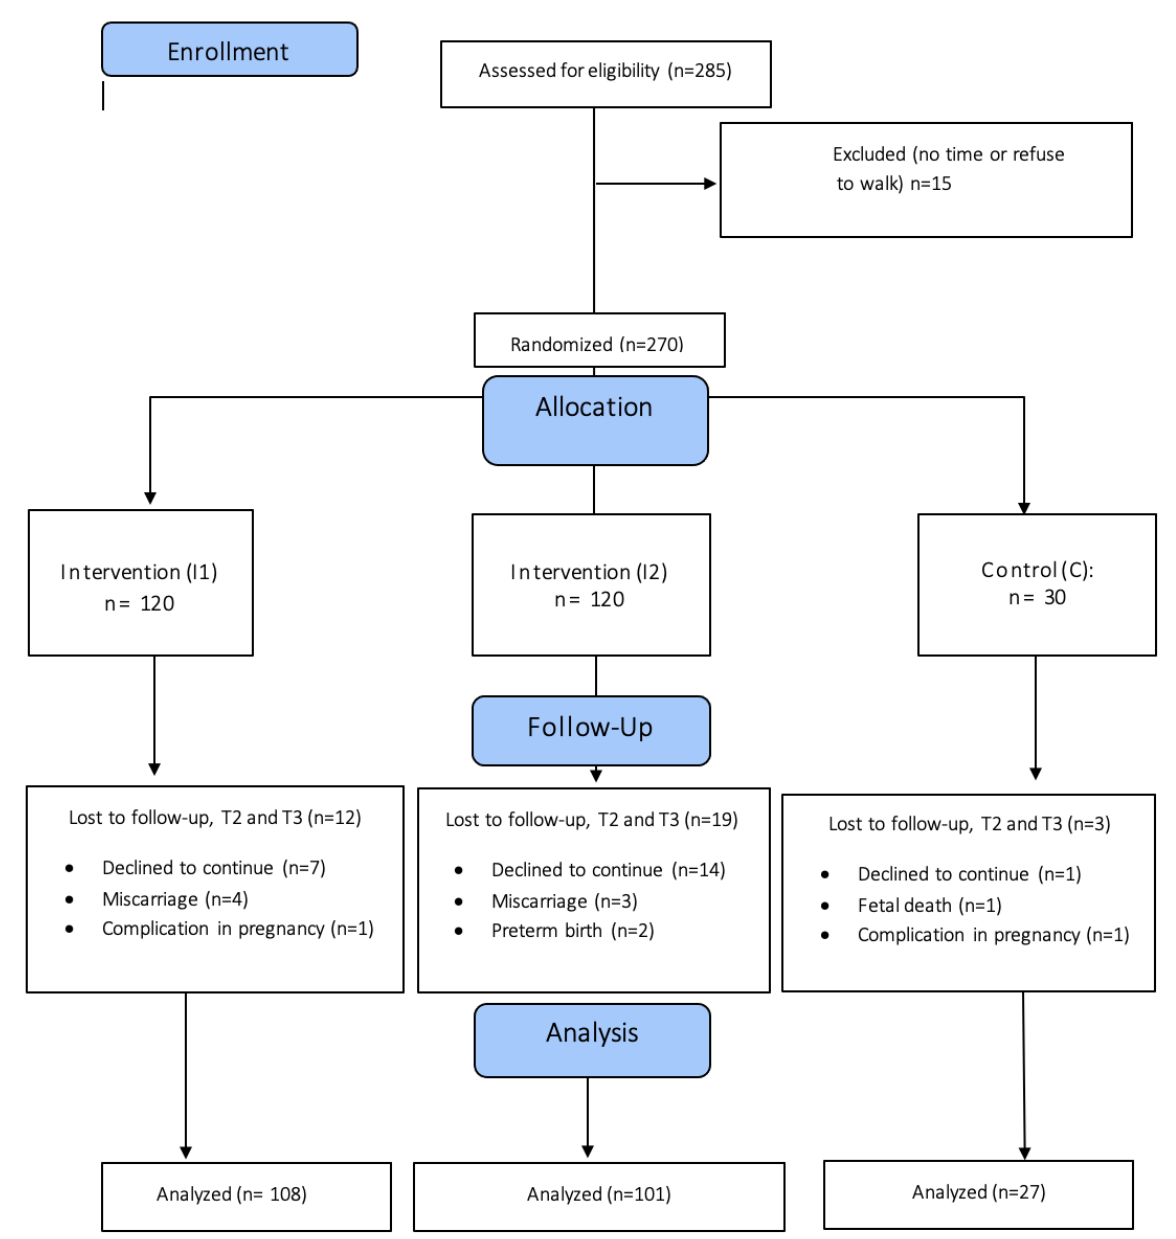
Figure 1. Flow chart. I1: maximum intervention group: pedometer, goal of 10,000 steps and reminder; I2: minimum intervention group: pedometer, without steps goal; C: control group: without pedometer, but with physical activity recommendations; T: Interview time; T2: second trimester; T3: third trimester.